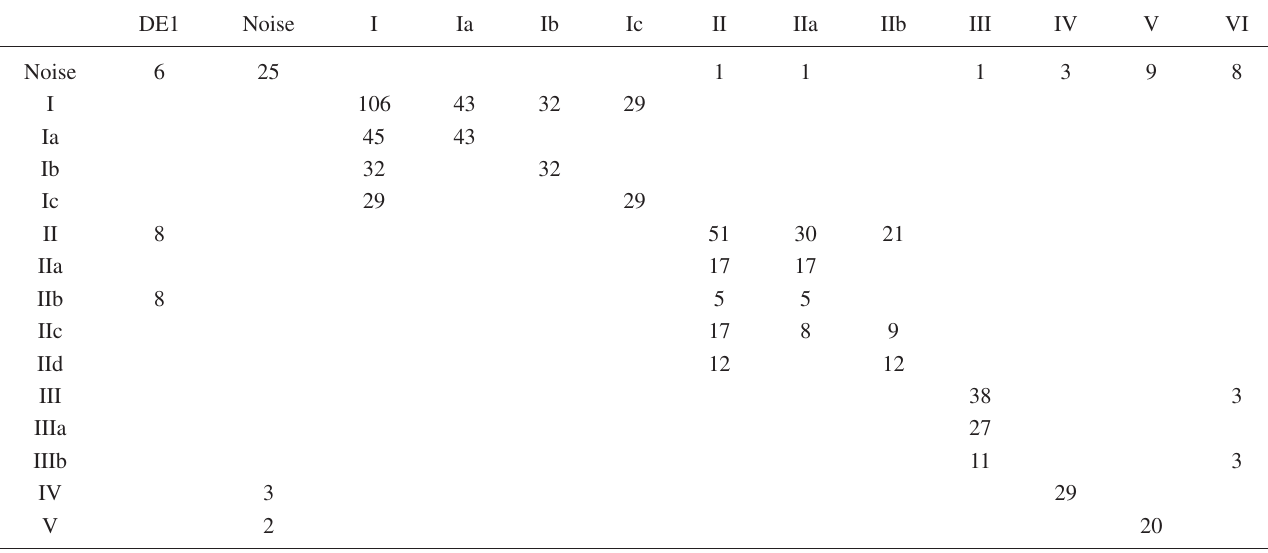
TABLE II. Cross comparison of groups found using the Jaccard (cid:1) down (cid:2) and squared Euclidian (cid:1) across (cid:2) distances. Cell values of “0” have been omitted for the sake of clarity. N